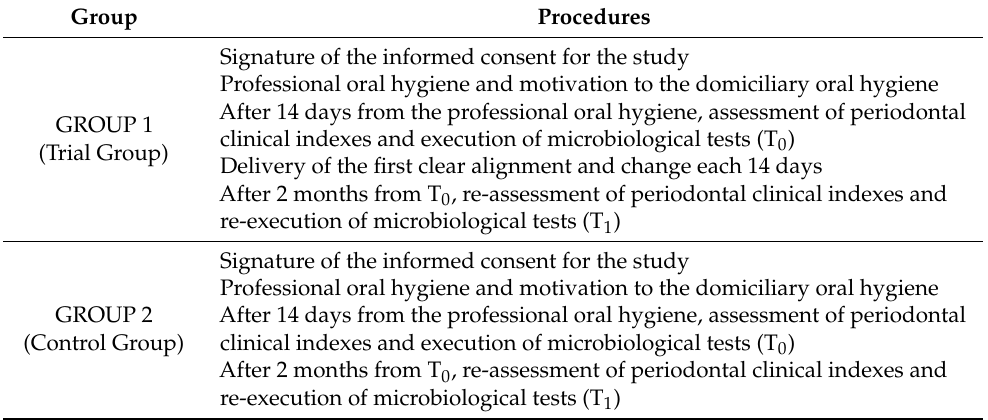
Table 2. Protocol of the study.